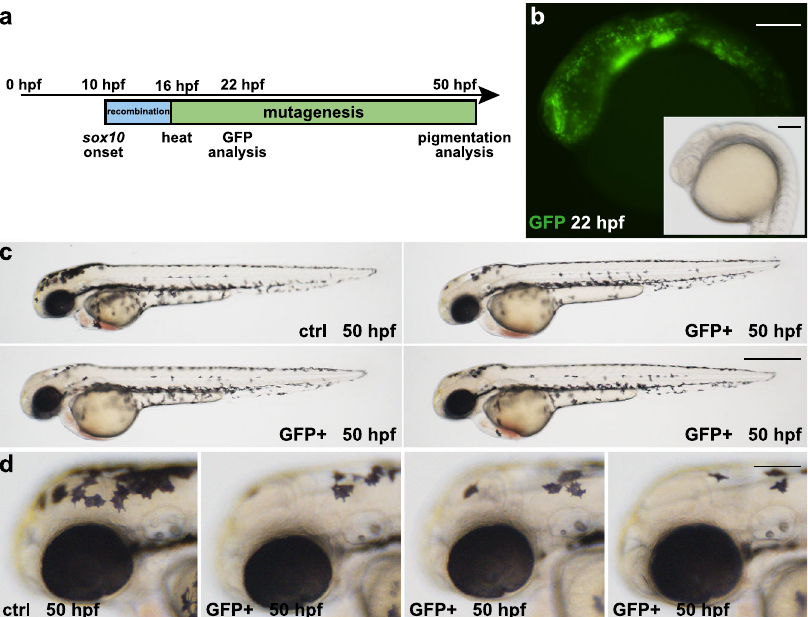
Fig. 4 sox10 -speci fi c Cre activity results in spatiotemporally controlled GFP expression and pigmentation defects along the body. a Timeline. Cre activity in sox10 :Cre-positive animals at 10 hpf elicits recombination (blue box) in developing neural crest cells. At 16 hpf, a heat treatment triggers expression of Cas9-GFP and the subsequent permanent mutagenesis of the tyr target site (green box). Analysis of GFP expression and pigmentation was conducted at 22 and 50 hpf, respectively. b Expression of GFP is detected in neural crest cells at 22 hpf. c , d In comparison to controls (ctrl), GFP-positive embryos (GFP + ) display a loss of pigmentation in the anterior head region. Examples shown are representatives across eight experiments showing the same result. A total of >160 GFP-positive individuals and their respective non-GFP-positive siblings were analyzed. Scale bars: 150 µ m in b and d ; 500 µ m in c